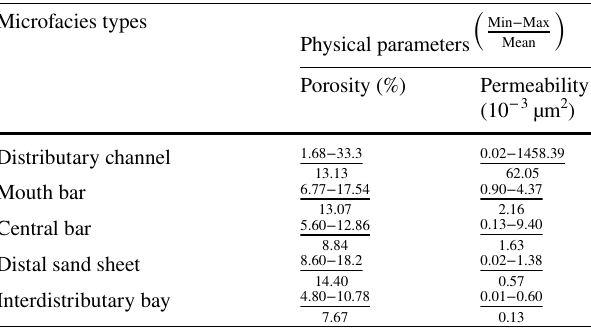
Table 3 Statistical table of relationship between physical parameters and microfacies in the Lengdong